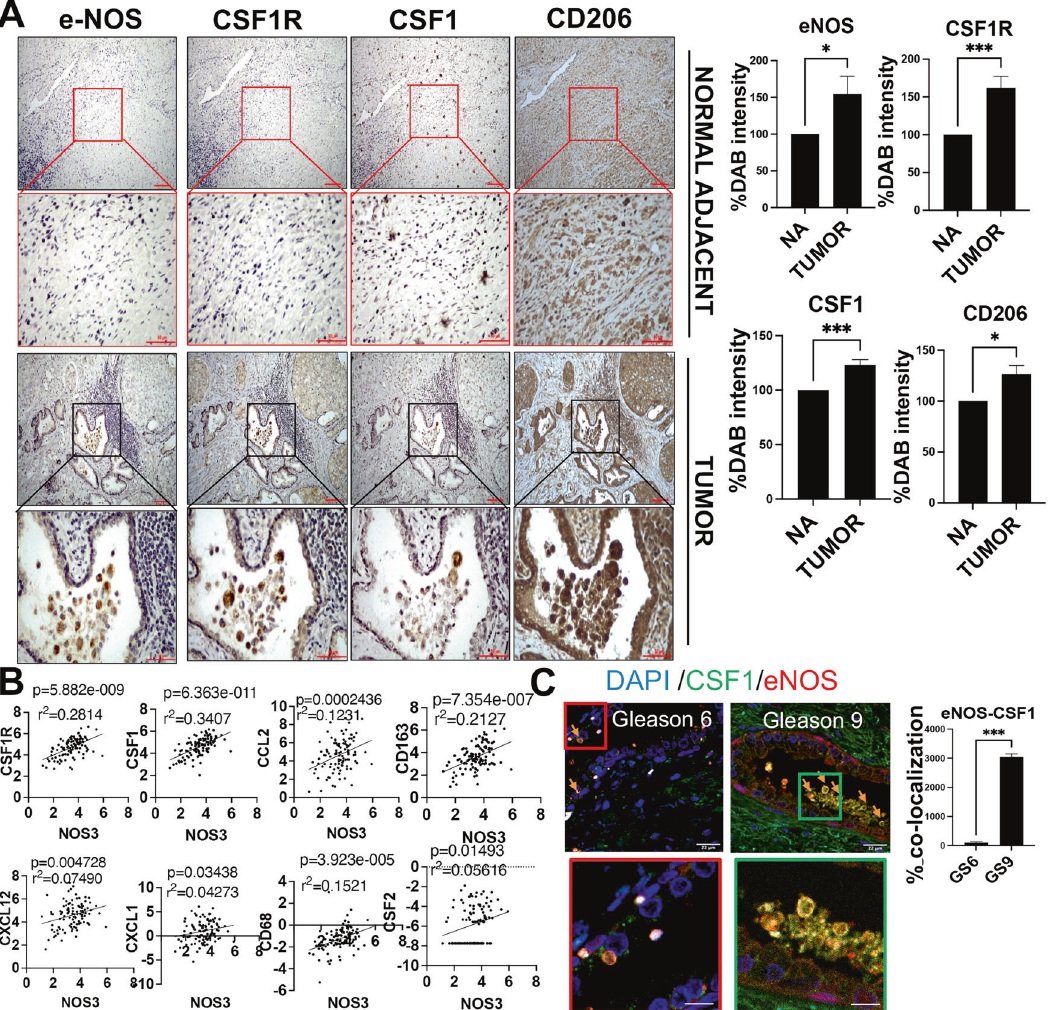
Fig. 2 NOS3 expression in prostate cancer biopsies is correlated with enrichment of CSF1 + , CSF1R + , and CD206 + cells. A Representative images of NOS3, CSF1R, CSF1, and CD206 immunostaining selected from a tumor region with either high or low NOS3 expression in a patient biopsy sample. The red and blue square in the upper panel indicates a region of interest that has been magni fi ed in the lower panels. Scale bar, 100 μ m. B Matrix of scatterplots showing correlations between CD8A, CD8B, CSF1, CSF1R, CD68, and CD163 gene expression speci fi c to high-grade prostate cancer (Gleason grade 9) of TCGA. The correlation was assessed using Spearman ’ s correlation coef fi cient. Black lines indicate the local regression (LOESS) fi t. P , P value; n , number of samples; r 2 , Spearman ’ s correlation coef fi cient. C Representative multiplexed fl uorescence staining images of tumor tissue from one prostate biopsy patient stained with 4 ′ ,6-diamidino-2-phenylindole (DAPI) (blue), and antibodies against CSF1 (green) or NOS3 (red). Percentage of co-localization for CSF1 + NOS3 + cells are represented for the patients listed in Table S1 ( n = 3). Data are means ± SEM of three images per tumor area for each patient. * p < 0.05; *** p <